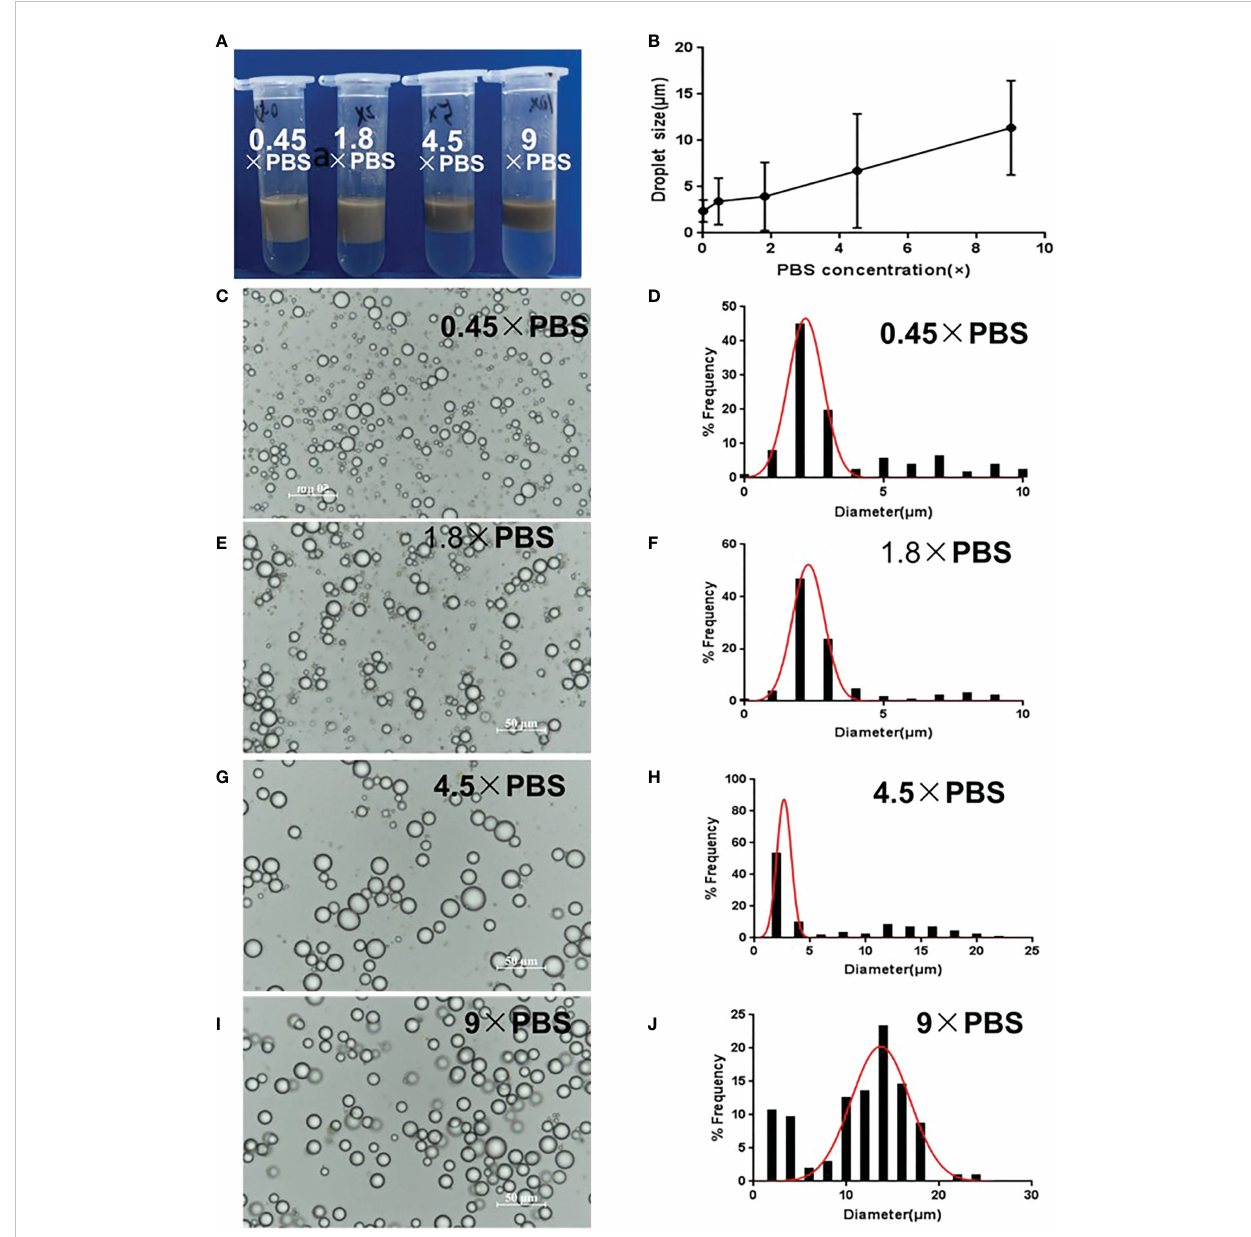
FIGURE 2 Optimization of GPE based on different salinities. (A) Appearance of GPEs prepared at different salinities; (B) the average droplet size as a function of salinity; (C) GO dispersions diluted to 1 mg/mL with different concentrations of PBS; (D) GO dispersions with different salinities when mixed with squalene; (C, E, G, I) optical micrographs and (D, F, H, J) droplet size distributions of the GPEs prepared at different salinities. Preparation conditions: water/oil ratio 10:2, GO concentration 1.0 mg/mL, sonication at 163 W for 2 min. GO, graphene oxide; GPE, GO-stabilized Pickering emulsion; PBS, phosphate-buffered